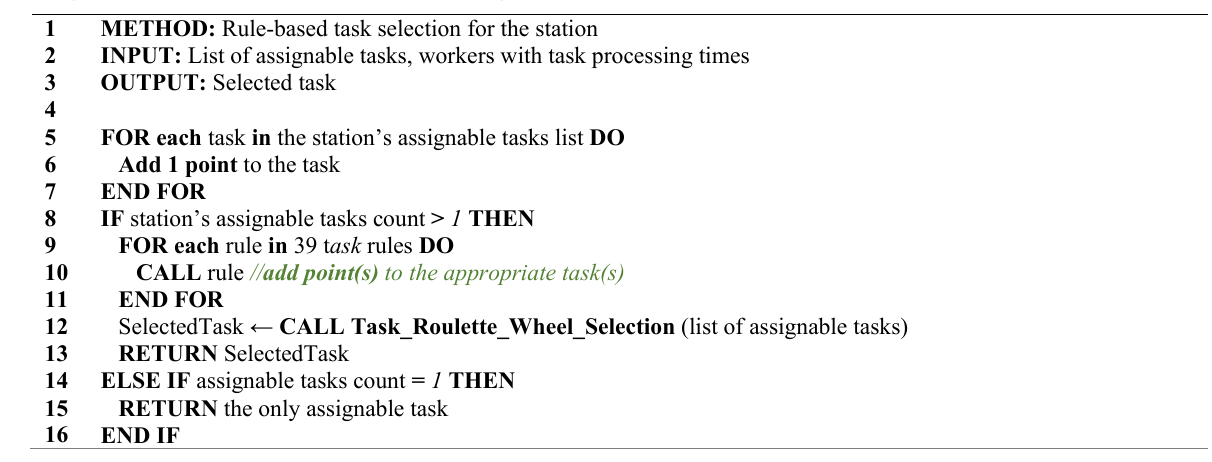
Algorithm 1: The rule-based task selection